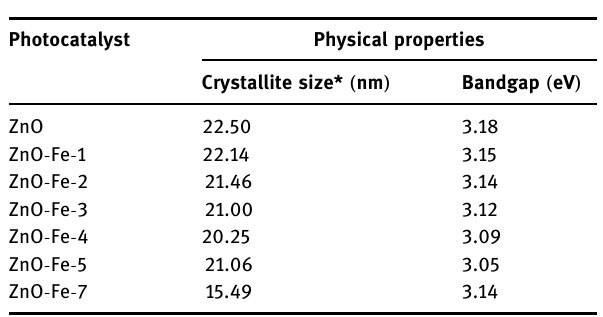
Table 1: Crystallite size and bandgap value of the undoped ZnO and Fe - doped ZnO metal oxide NPs